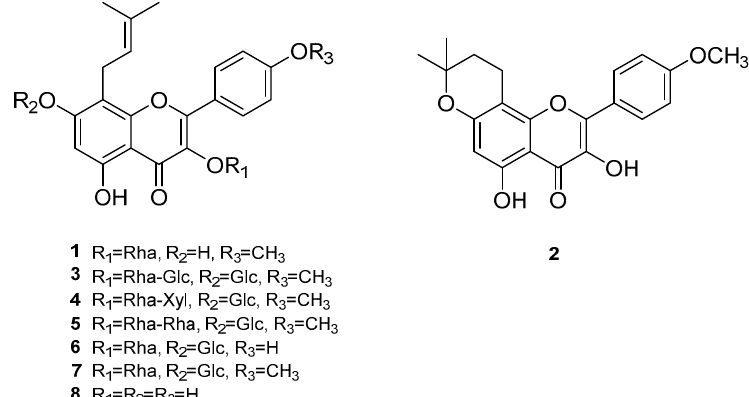
Figure 1. Chemical structures of compounds 1 – 8 ; ( 1 ) anhydroicaritin 3- O -rhamnoside, ( 2 ) β -anhydroicaritin, ( 3 ) epimedin A, ( 4 ) epimedin B, ( 5 ) epimedin C, ( 6 ) epimedoside A, ( 7 ) icariin, and ( 8 ) des- O -methyl- β -anhydroicaritin.